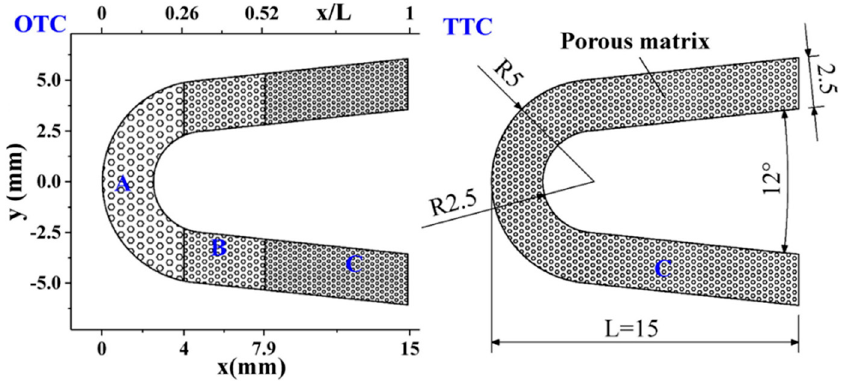
Figure 35. Geometry of the two transpiration cooling configurations (unit: mm). Reprinted with permission from [131]. Copyright 2018 Elsevier.